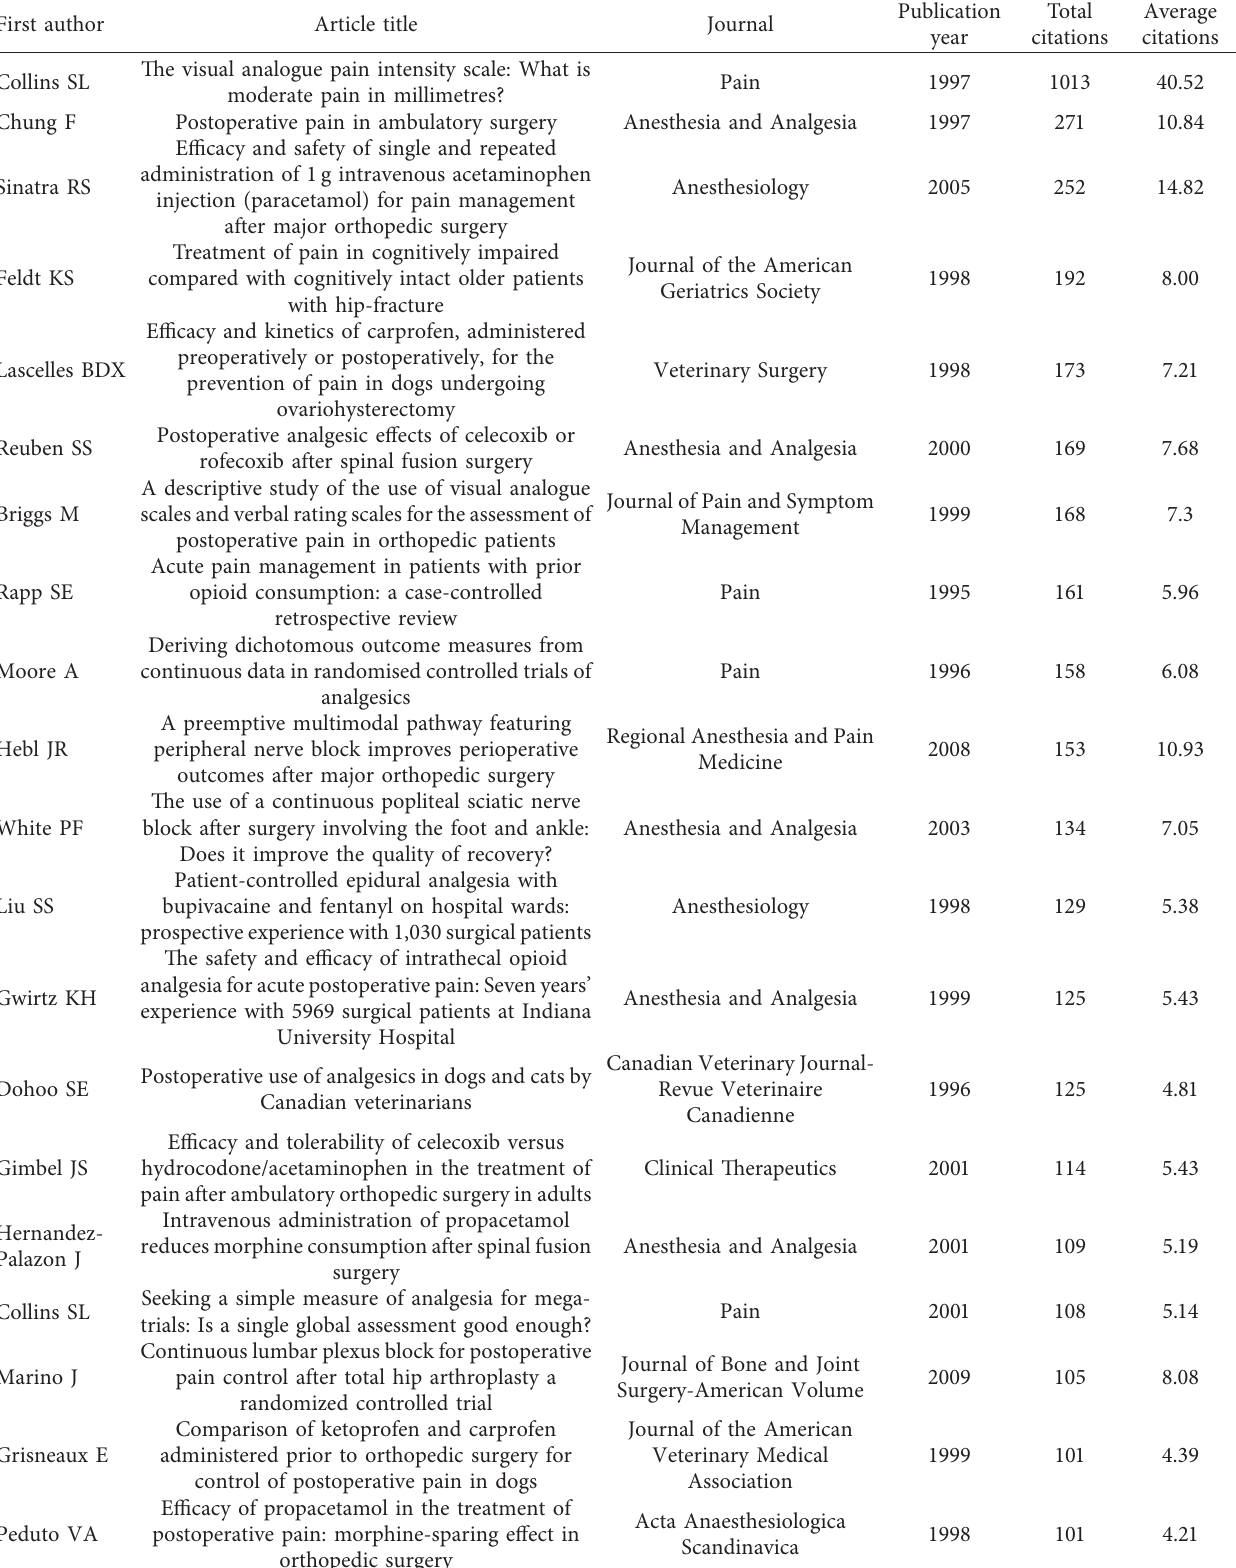
Table 1: Top 20 most cited articles on analgesics in the treatment of orthopedic postoperative